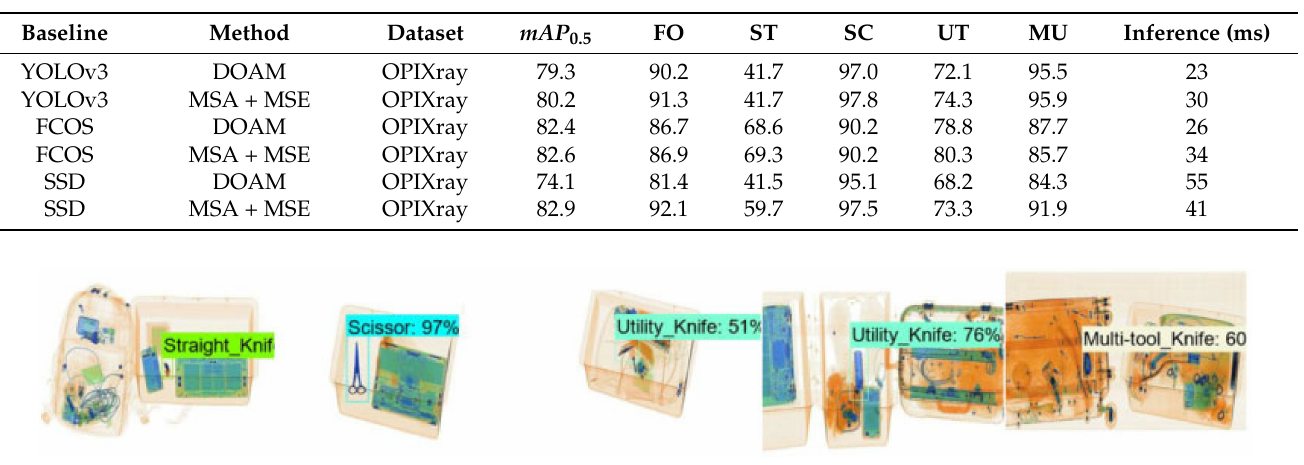
Table 7. OPIXray contrast experiments.